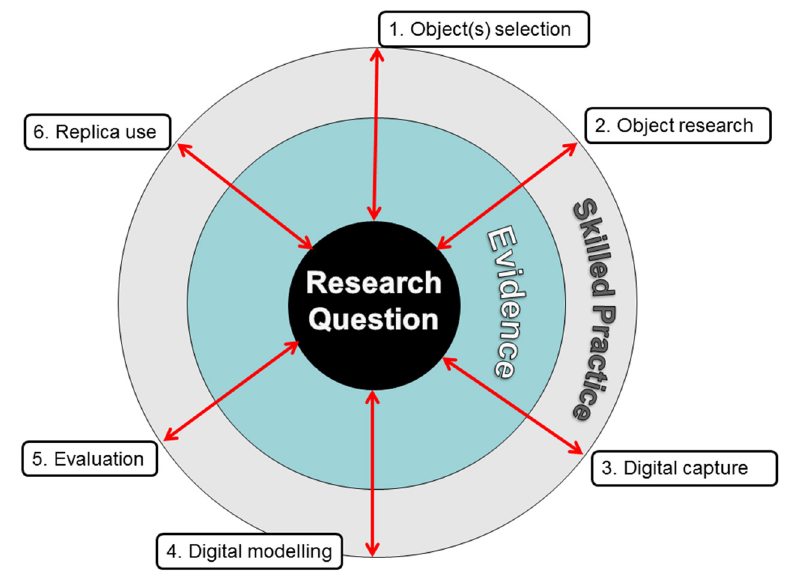
Figure 4. Our model, as utilised by the NU Digital Heritage